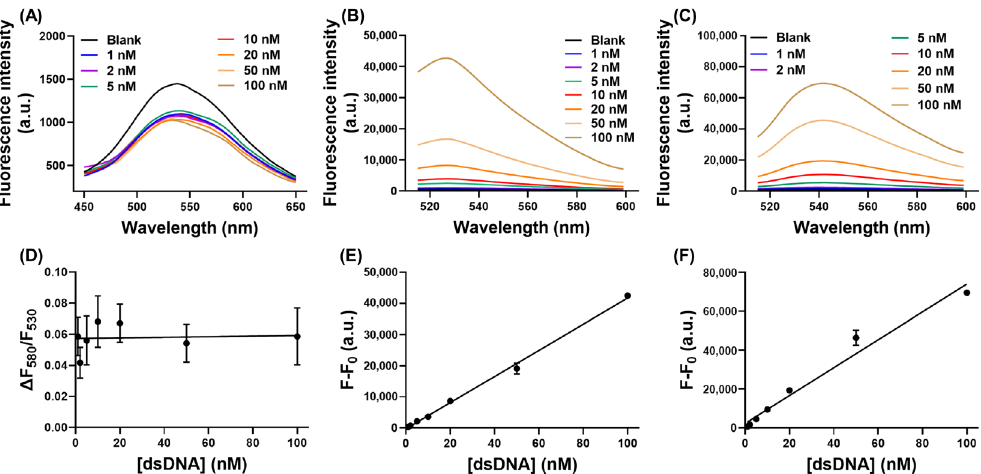
Figure 5. The fluorescence spectra of PMNT ( A ), SGI ( B ), and SYBR Gold ( C ) in response to different concentrations of dsDNA. ( D ) The fluorescence ratio of PMNT as a function of dsDNA concentration. The fluorescence intensity changes of SGI ( E ) and SYBR Gold ( F ) in response to dsDNA concentration. The concentration of PMNT was 5 μM, and the concentration of SGI and SYBR Gold was 0.5×.